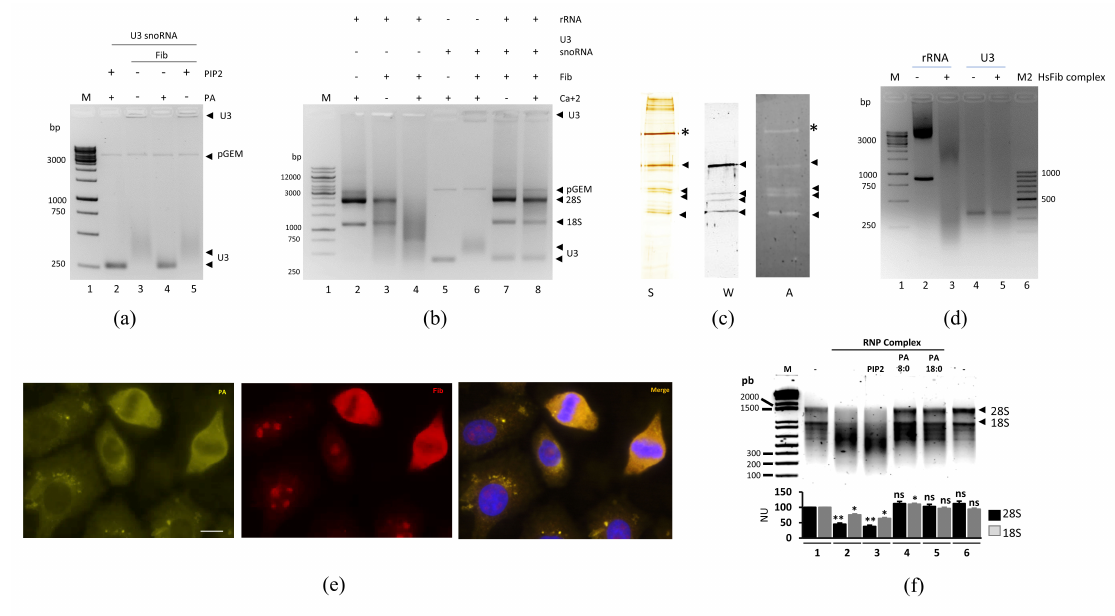
Figure 3. RNA specific RNA activity by fibrillarin with snoRNA U3. ( a ) Gel shift of snoRNA U3 with WT fibrillarin. All incubations and procedures carried out at 4 ◦ C, PIP2 and PA were added as indicated. Plasmid control pGEM was used to normalize each lane. ( b ) RNA activity of fibrillarin with or without guide snoRNA U3 added. Reactions were carried out at 37 ◦ C. ( c ) In-gel RNA activity of native fibrillarin RNP complex, labeled with silver staining (S), revealed by Western blot (W) and tested by activity assay (A). Arrowheads indicate fibrillarin and potential degradation products, and an asterisk indicates an undetermined ribonuclease activity ( d ) In vitro RNA activity of HeLa expressed and purified SNAP-tag–fibrillarin complex against total RNA and snoRNA U3. ( e ) Immunofluorescence showing the colocalization of PA and fibrillarin. The signal corresponds as follows: Blue–DAPI (nucleus signal), Yellow–PA sensor, and RED–fibrillarin. ( f ) In vitro RNA assay using PA. An inhibition e ff ect was observed using PA containing 8 or 18 carbons and no saturation in the lateral chains (8:0 or 18:0), whereas little e ff ect on the activity was observed with PIP2. Quantification of 28S and 18S signals were made by ImageJ software and statistical significance was determined by t -test (* p -value < 0.05; ** p -value < 0.01; *** p -value < 0.001, ns = not significant p -value > 0.05) and plots are indicated below the gels from n =